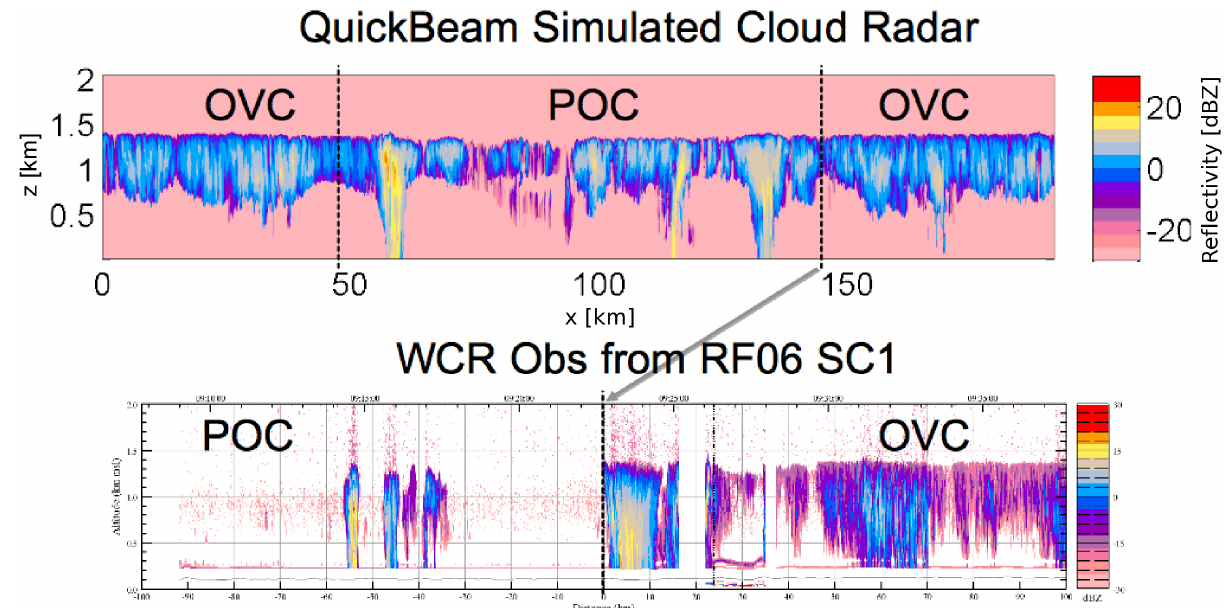
Fig. 9. Comparison of QUICKBEAM simulated cloud radar field to RF06 Wyoming Cloud Radar observations. Plots are on identical spatial and color scales.